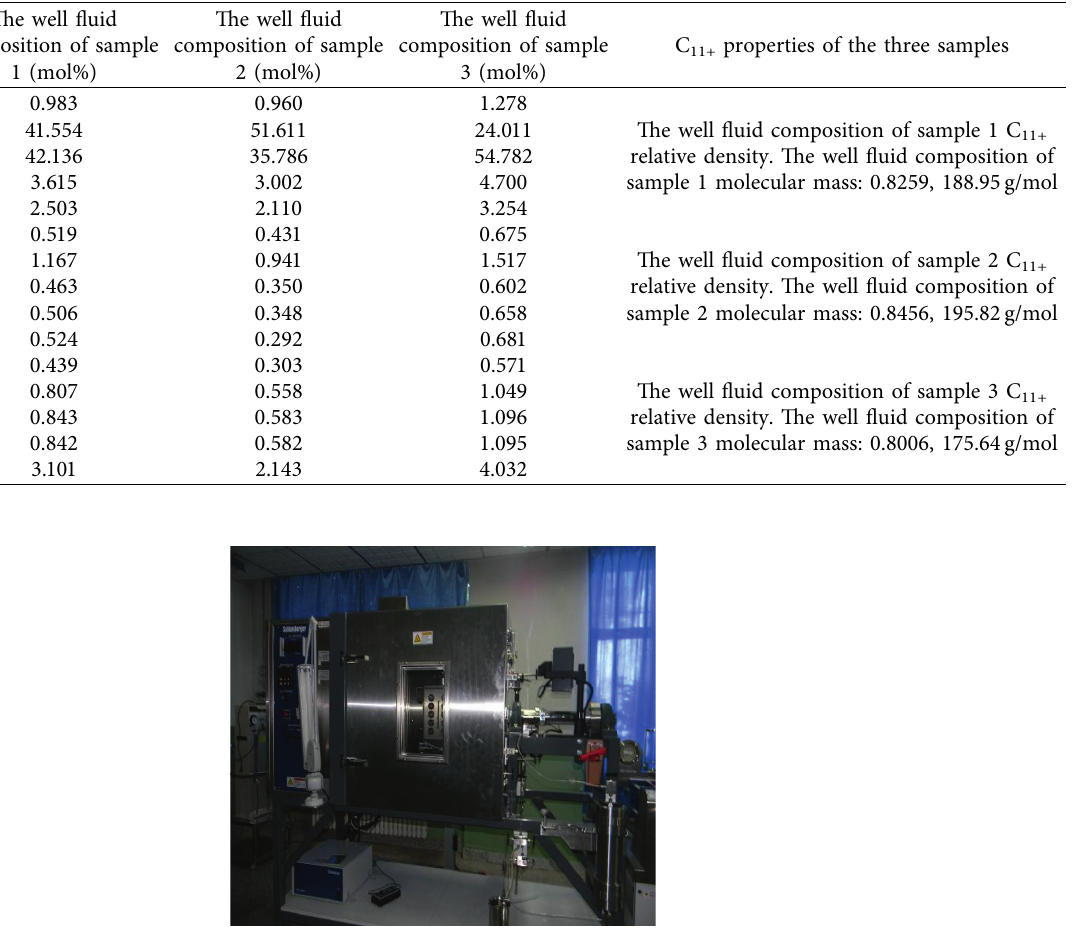
Table 2: The well fluid composition of three condensate gas samples with different CO